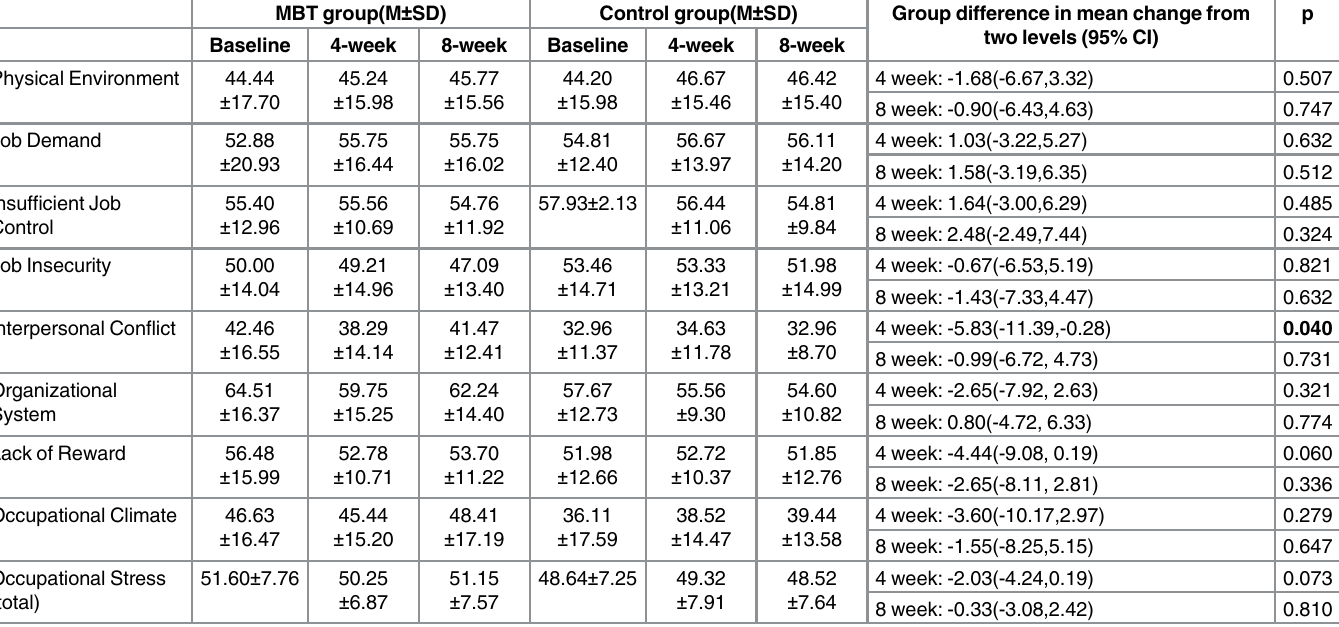
Table 1. Differences in KOSS scale scores for the MBT and control groups at baseline, 4 weeks and 8